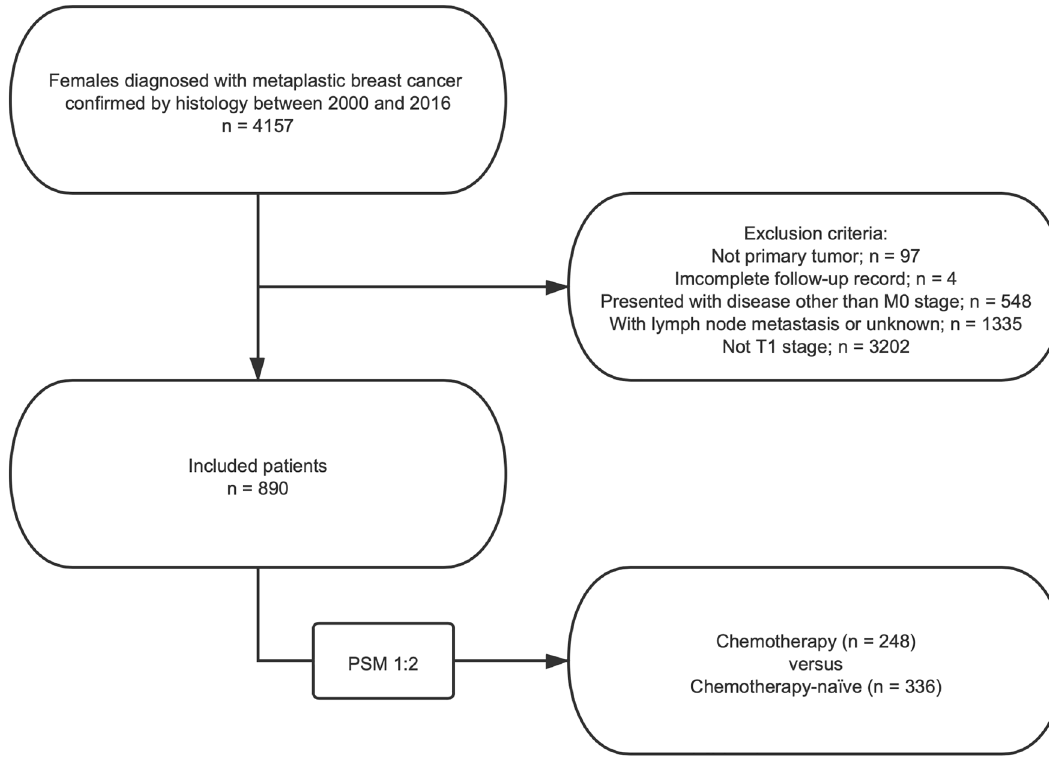
Figure 1. Flow diagram for the study cohort. Abbreviation: PSM, propensity score